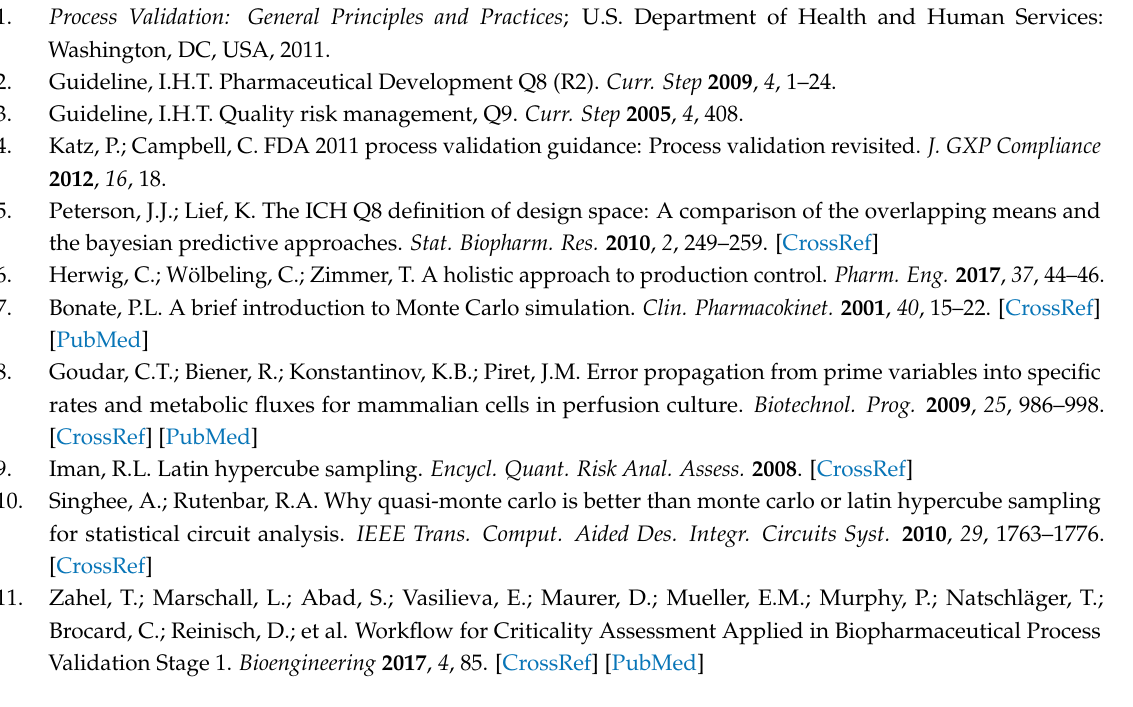
Figure S1: Comparison of simulated ( top ) product-related impurity 1 distribution and observed ( bottom ) product-related impurity 1 from LS after each column step, Figure S2: Comparison of simulated ( top ) product-related impurity 2 distribution and observed ( bottom ) product-related impurity 2 from LS after each column step, Figure S3: Comparison of simulated ( top ) process-related impurity 2 distribution and observed ( bottom ) process-related impurity 2 from LS after each column step, Figure S4: Comparison of simulated ( top ) process-related impurity 1 distribution and observed ( bottom ) process-related impurity 1 from LS after each column step, Table S1: Overview of found models based on DoE data, Table S2: Overview of models showing a correlation between specific CQA clearances and CQA load